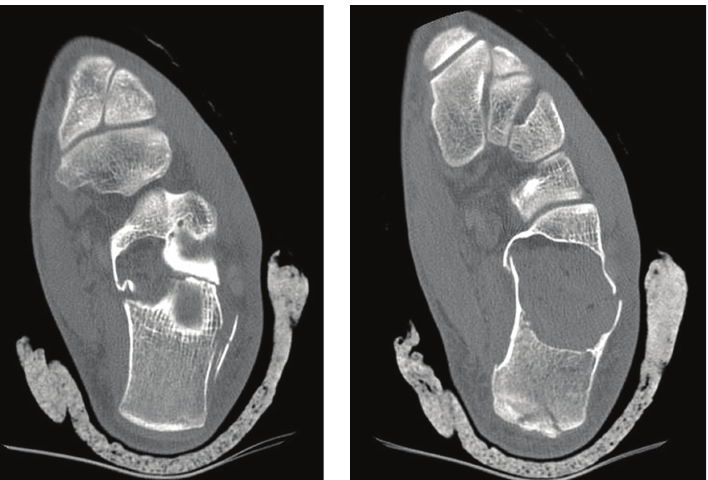
Figure 2: CT scan views on the transverse plane showing an undisplaced pathologic fracture over a simple calcaneal